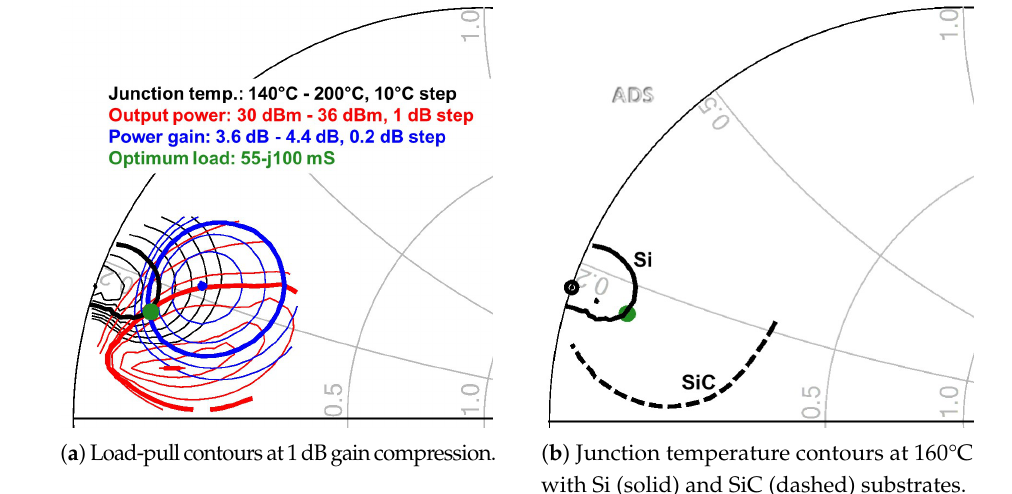
Figure 6. Load-pull simulation results of the 8 × 75 µ m device at 36GHz, with T BS = 80 ◦ C and at the selected bias